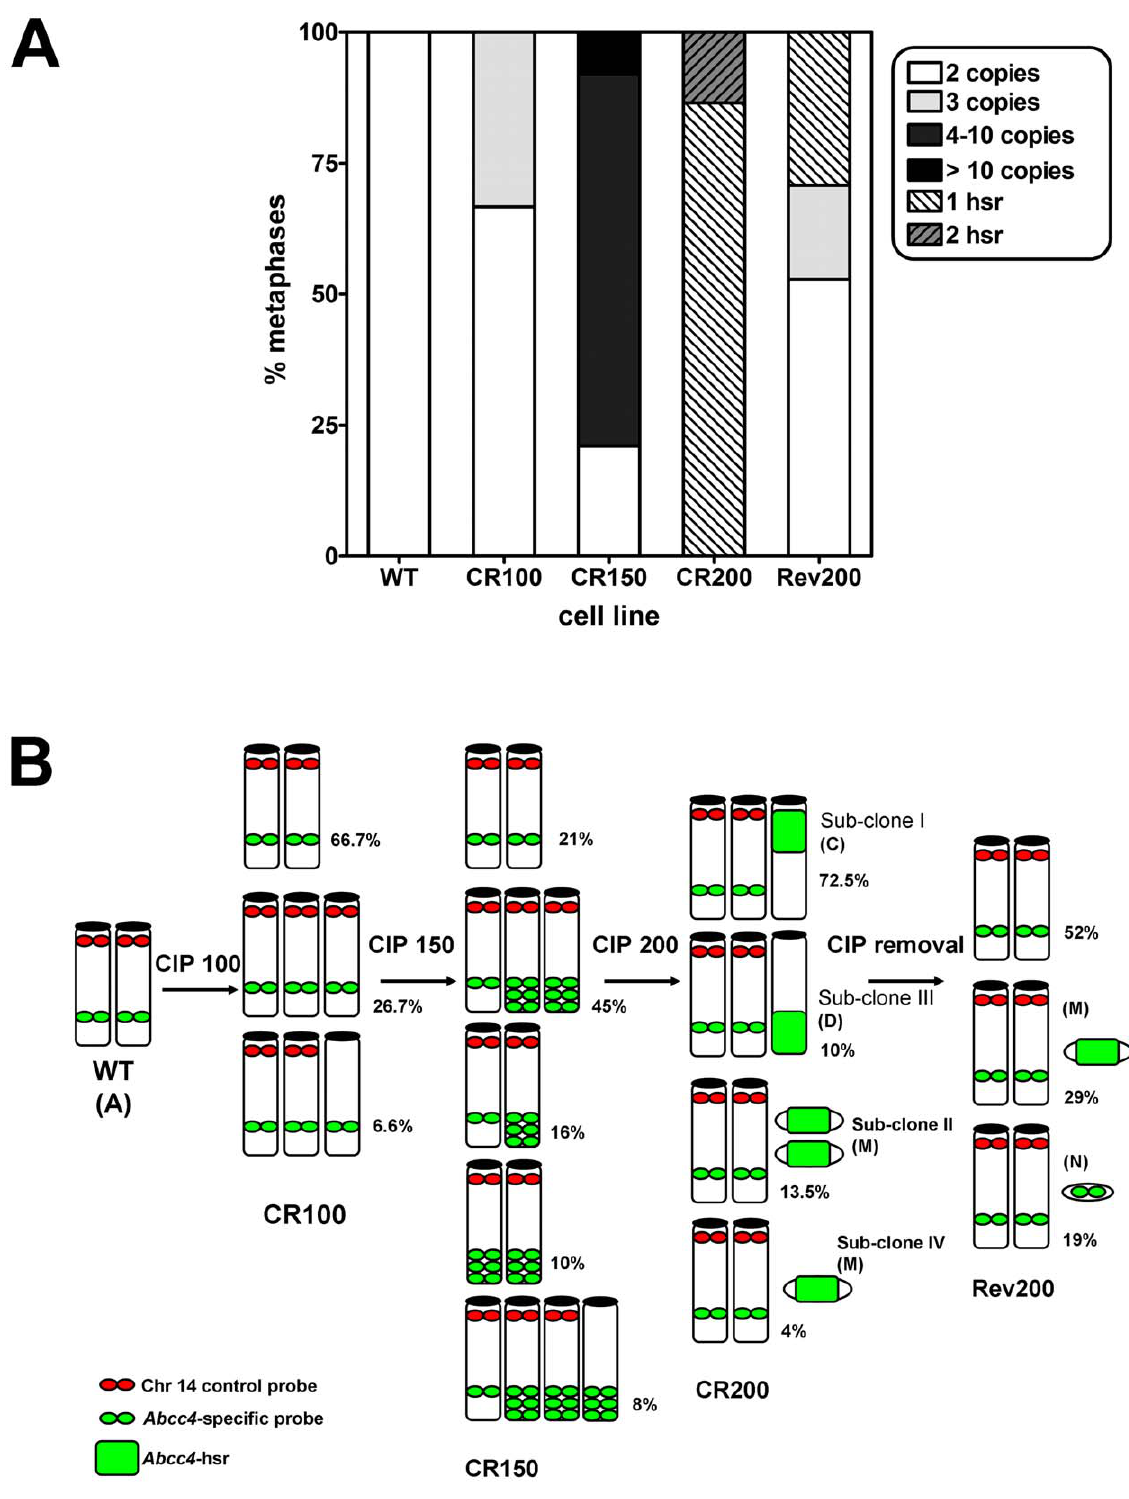
Figure 3. Abcc4 copies detected by FISH on metaphases of cultured macrophage cell lines. A. Relative abundance of the clones according to number of Abcc4 copies detected by FISH in the different cell lines (WT: wild-type cells; CR100, 150, and 200: cells resistant to 100, 150, and 200 m M of ciprofloxacin; Rev200: revertant cells). Hsr, homogeneous staining region. B. Schematic representation of chromosomes with Abcc4 copies in the same cell lines (only chromosomes with Abcc4 copies are shown; Chr der(14)T(3;14)(E2;C?1) (Chr B), present in almost all clones, but which lacks Abcc4 locus, is not represented). Percentages refer to the relative abundance of each clone, and letters between brackets to Chromosomes as identified in Figure 2.